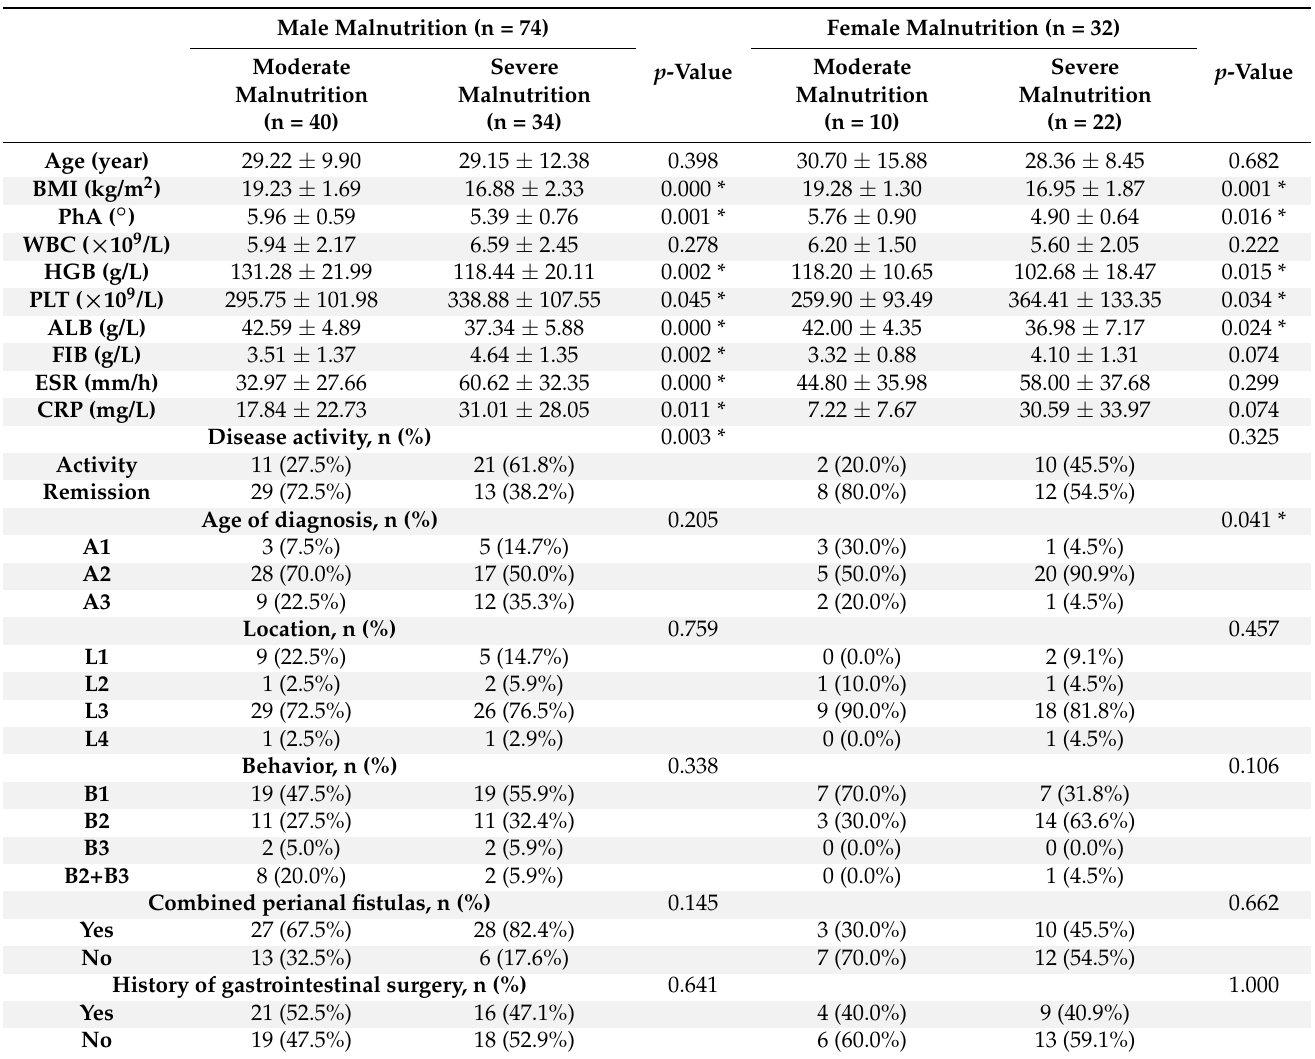
Table 4. Comparison of patient characteristics, body composition, and clinical data between moderate malnutrition and severe malnutrition in